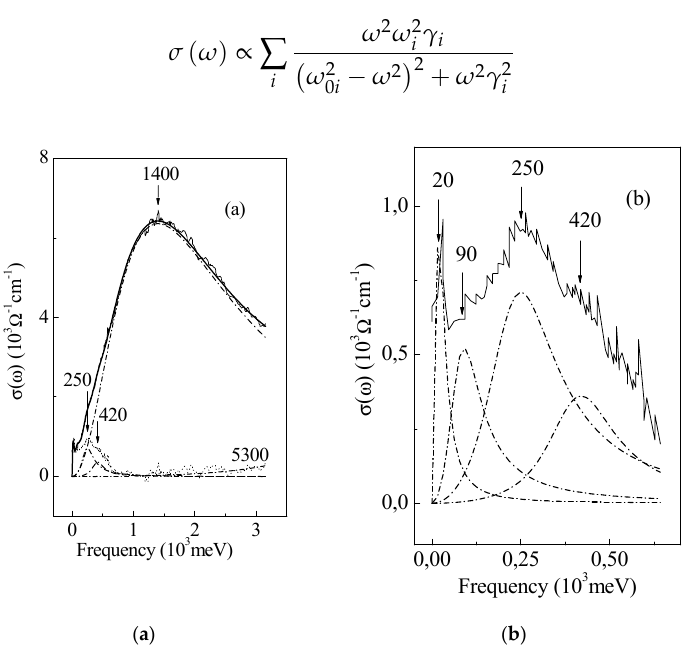
Figure 7. ( a ) Experimental optical conductivity of icosahedral Al 63 Cu 25 Fe 12 (thin solid line [39]). The dash-dotted line (1400) is a fit with the Lorentzian peak according to Equation (8). The dotted line is a residue after subtraction of the peak. Dash-dotted line (5300) is a fit with the Lorentzian peak according to Equation (8). Thick solid line is a fit with a sum of this Lorentzian peak and peaks in ( b ). ( b ) The residue shown in ( a ) but on an enlarged scale (solid line). Dash-dotted lines (20, 90, 250, and 420) are the fit with the Lorentzian peaks according to Equation (8).